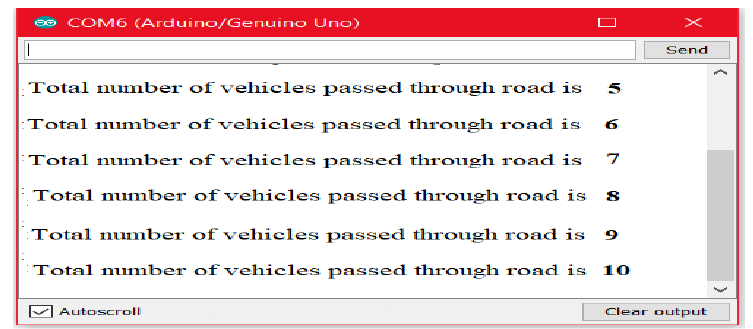
Figure 8. Serial monitor output according to traffic flow.